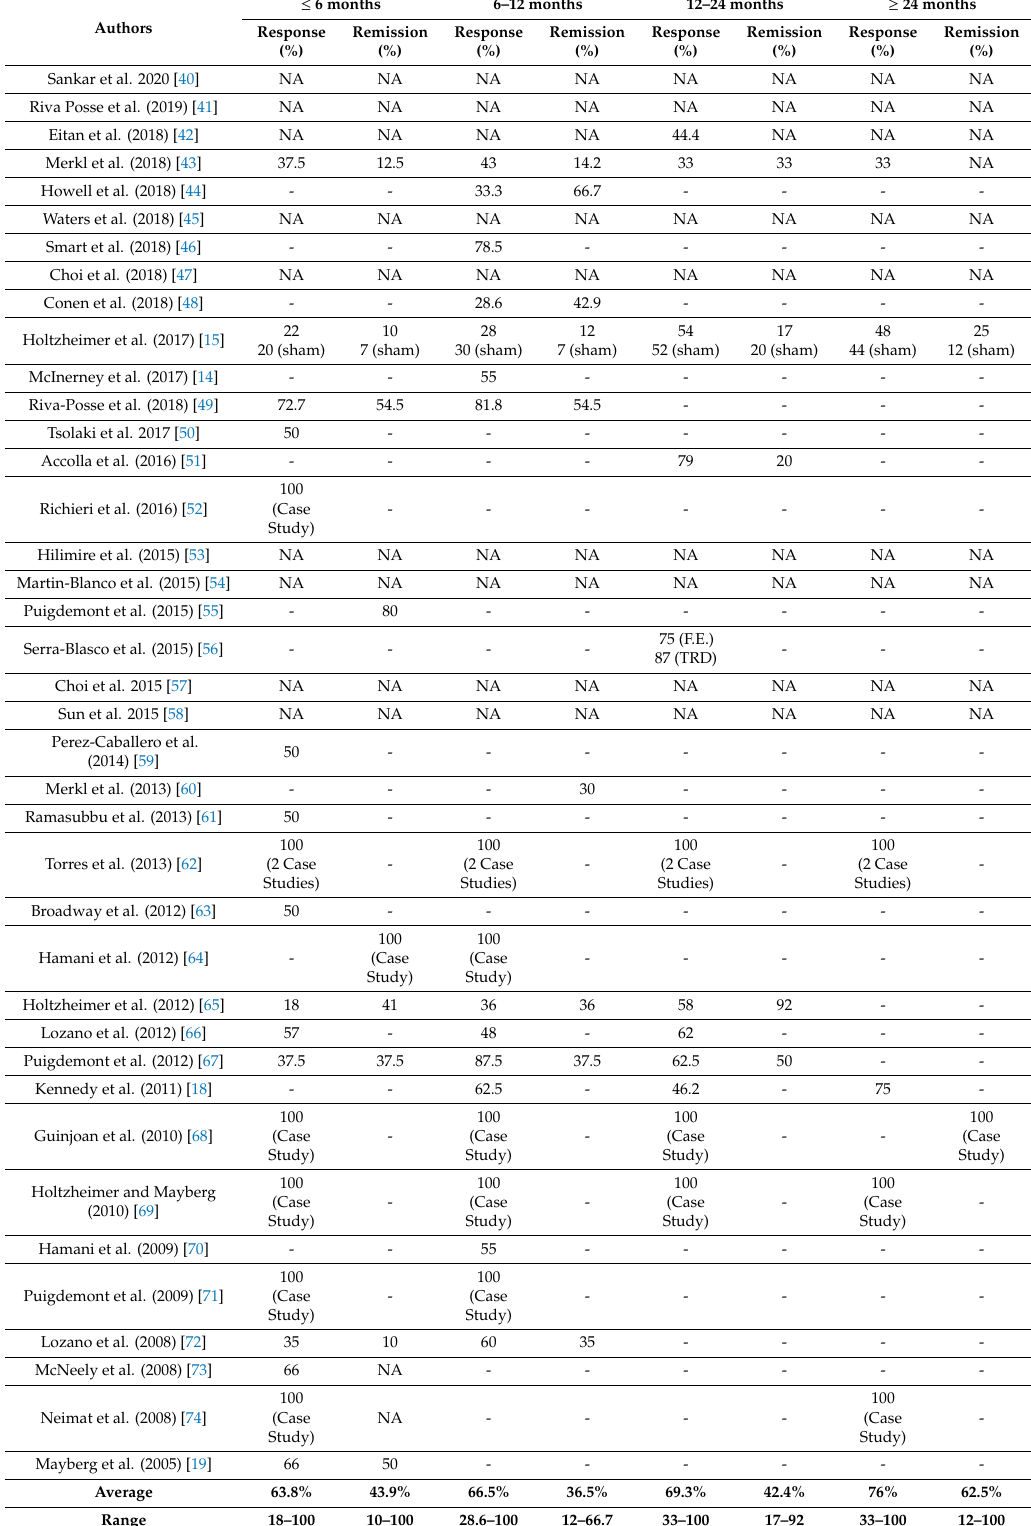
Table 2. Summary of response and remission rates from clinical